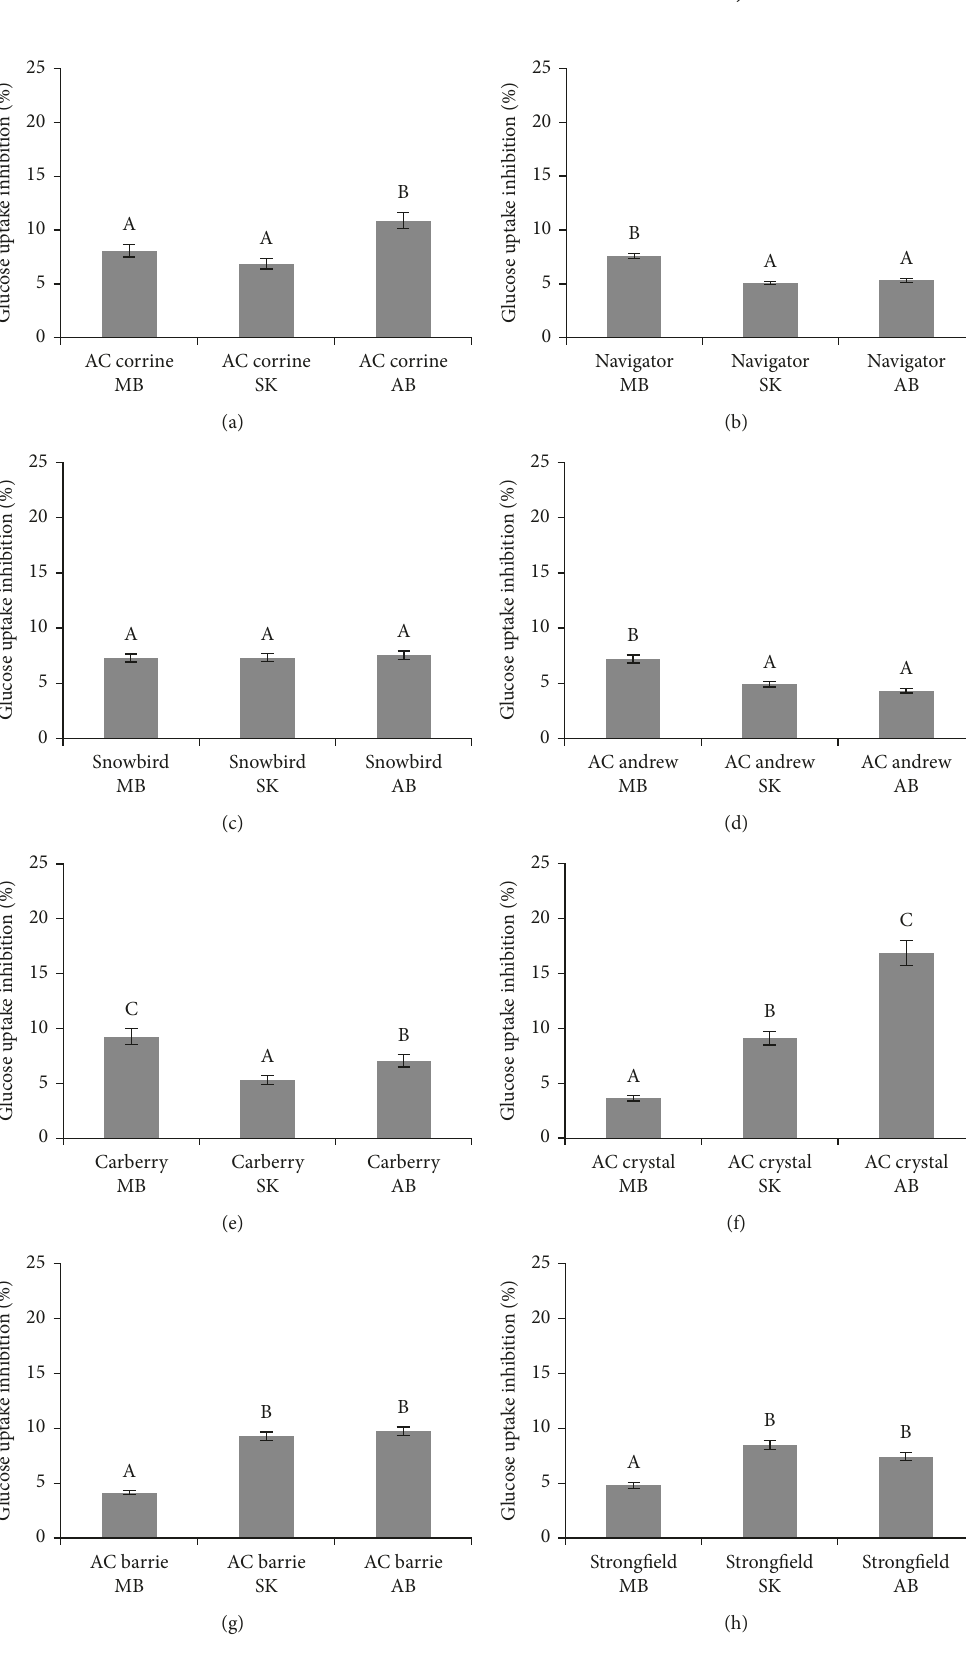
Figure 5: Relative inhibition of the uptake of [ 3 H] 2-deoxyglucose into CaCo-2 monolayers caused by extracts of bond phenolic acids obtained from eight wheat genotypes (a–h) grown in MB, SK, and AB over 2011 crop year. A,B,C Different capital letter superscripts indicate significant differences ( P 0 . <